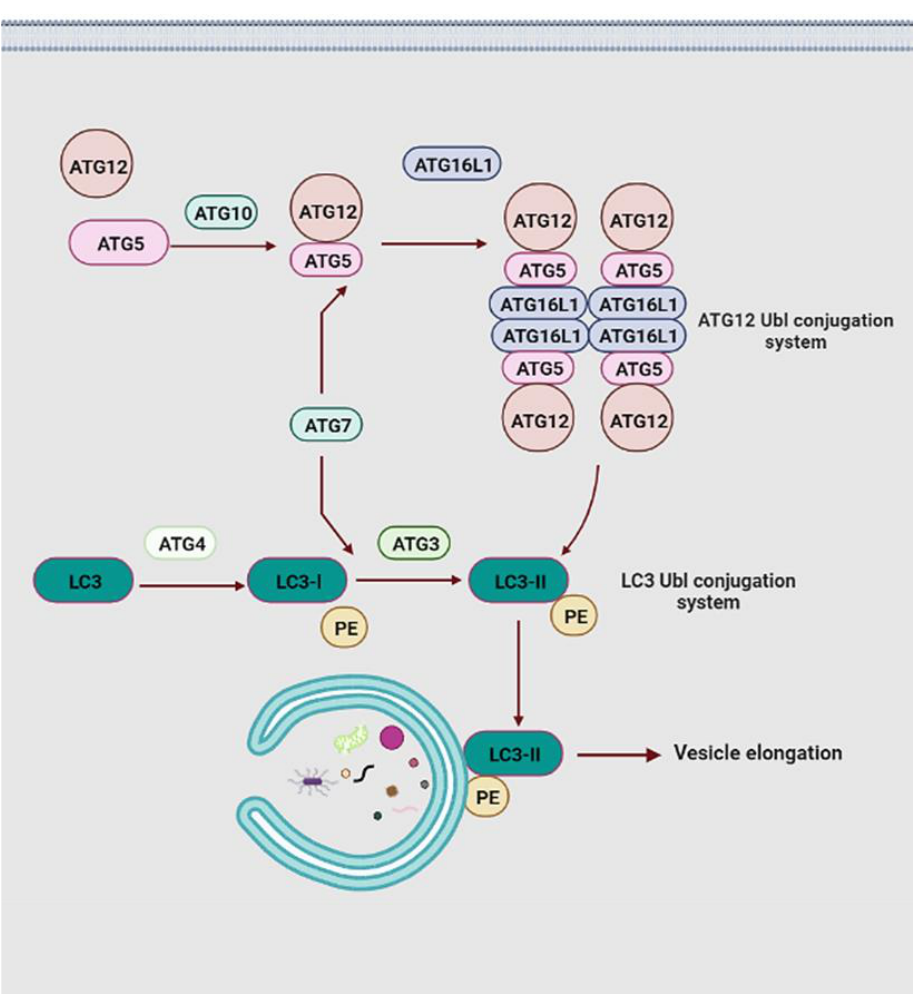
Figure 5. Schematic representations of vesicle elongation events. The elongation of the isolation membrane is mainly directed by two ubiquitin-like protein conjugation pathways. Abbreviations: PE, phosphatidylethanolamine.